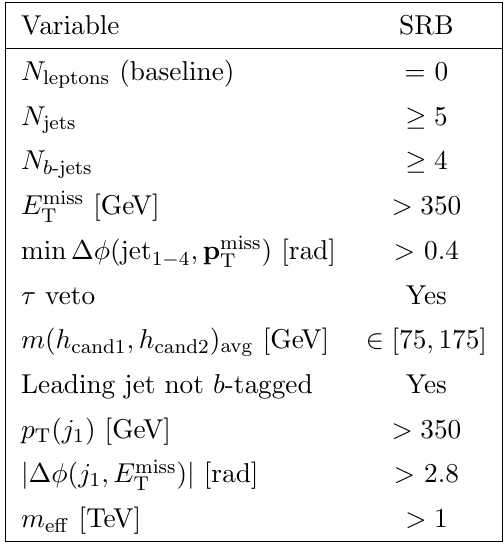
; ~ (cid:31) 0 ) = 130 GeV 2 1